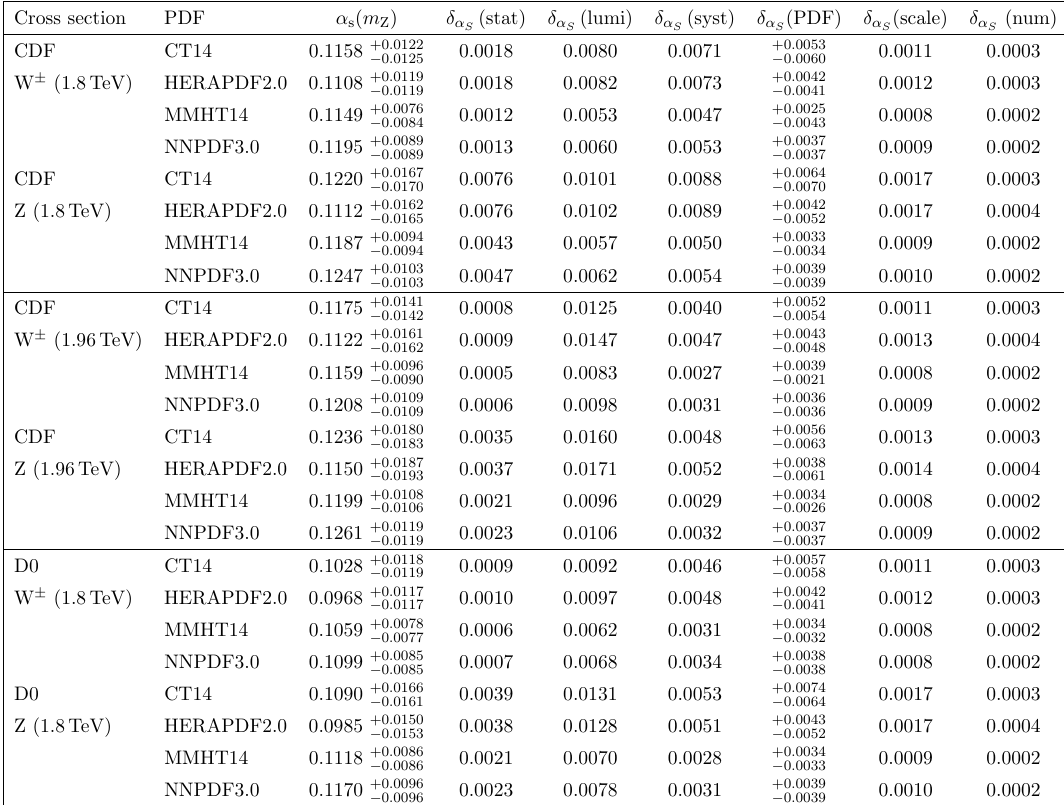
Table 17 . Extracted (cid:11) s ( m Z ) values from the comparison of the W + , W (cid:0) , and Z boson production cross sections measured by CDF and D0 to NNLO pQCD predictions. For each measurement, four results are extracted, one per PDF set. The breakdown of the propagated uncertainties from di(cid:11)erent experimental (statistical, integrated luminosity, and systematic) and theoretical (PDF, scale, and numerical) sources is provided for each (cid:11) s ( m Z )